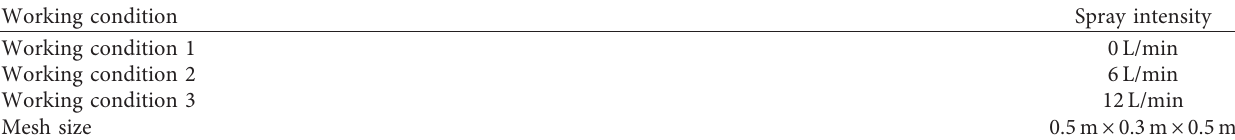
Table 13: Spray intensity at different conditions.